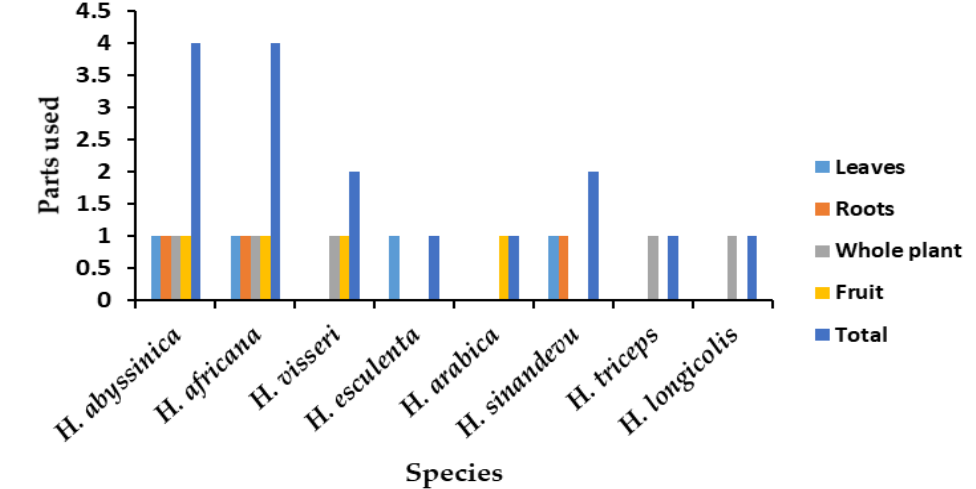
Figure 4. Utilized plant parts of Hydnora species .